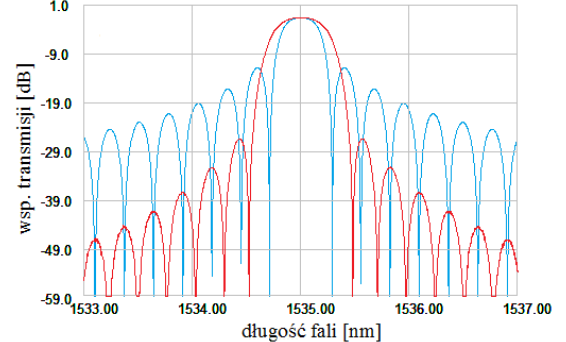
Fig. 19. Comparison of Bragg fiber gratings spectral characteristics without apodization – blue line and apodized sine function for wsp. X=1 and Y=1 – red line.